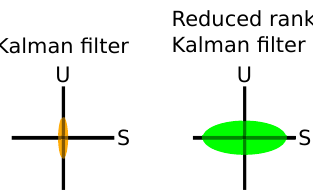
Figure 6. Conceptual diagram of the shape of the exact forecast er- ror covariance of the full rank Kalman filter and the exact reduced rank Kalman filter. The U axis represents the span of the unstable- neutral BLVs, where the forecast uncertainty projects most strongly in the standard (full rank) Kalman filter. The S axis represents the span of the stable BLVs, where the uncertainty is the largest (al- though bounded), for a reduced rank Kalman filter that neglects cor- rections to these modes. The comparison between the full rank and reduced rank Kalman filter covariance corresponds to the behavior exhibited in the curves in Fig.